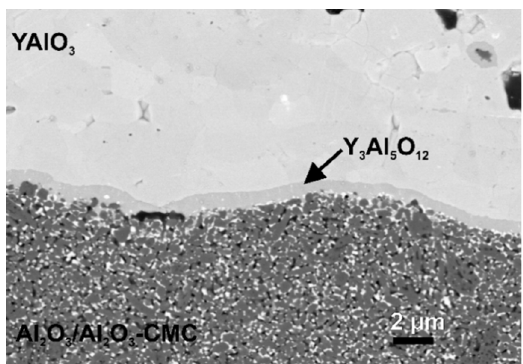
Figure 6. SEM image of the VLPPS YAlO 3 coating in the as-sprayed state, with a Y 3 Al 5 O 12 reaction layer at the coating substrate interface.